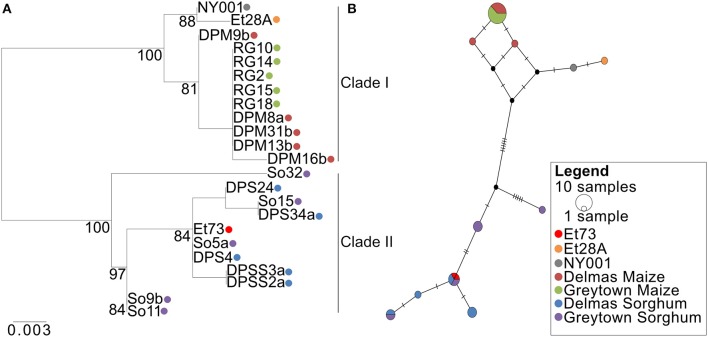
Phylogenetic relations of the SIX13-like effector among Exserohilum turcicum isolates from maize and sorghum shows host specificity. (A) A Maximum likelihood phylogenetic tree was drawn from 1,000 bootstrap repetitions and bootstrap values exceeding 75% are indicated in the graph. (B) Median-joining network of SIX13-like haplotypes based on nucleotide sequences. The size of the node represents shared haplotypes, and colors of the nodes are indicative of the host and location from where the isolates were collected. Black nodes represent missing or unsampled haplotypes. Bars represent mutational steps between haplotypes.